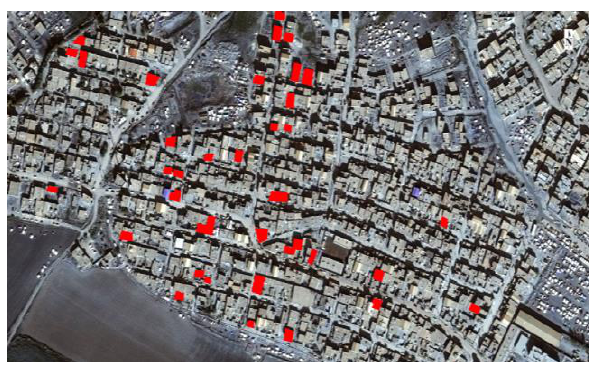
Figure 5. Part of ROIs in category "change"